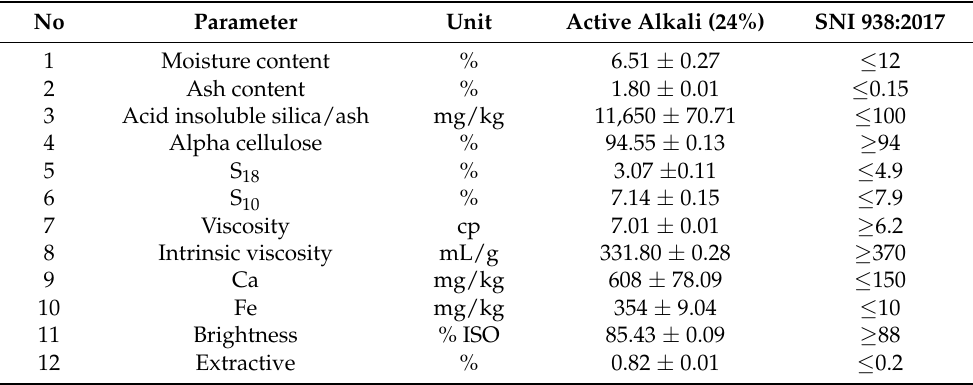
Table 8. Analysis results of dissolving pulp (DP) on whole-empty fruit bunches (WEFB) fiber with the addition of active alkali